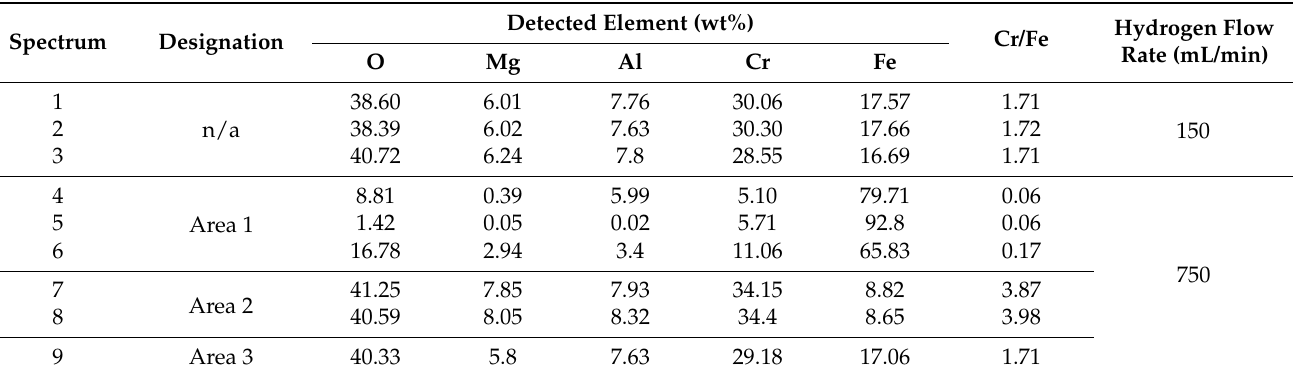
Table 3. Microanalyses by SEM-EDX (wt%) of chromite particles shown in Figure 6. The samples were reduced at 1100 C for 60 min at a hydrogen flow rate of 150 or 750 mL/min. The Cr/Fe ratio and hydrogen flow rate are